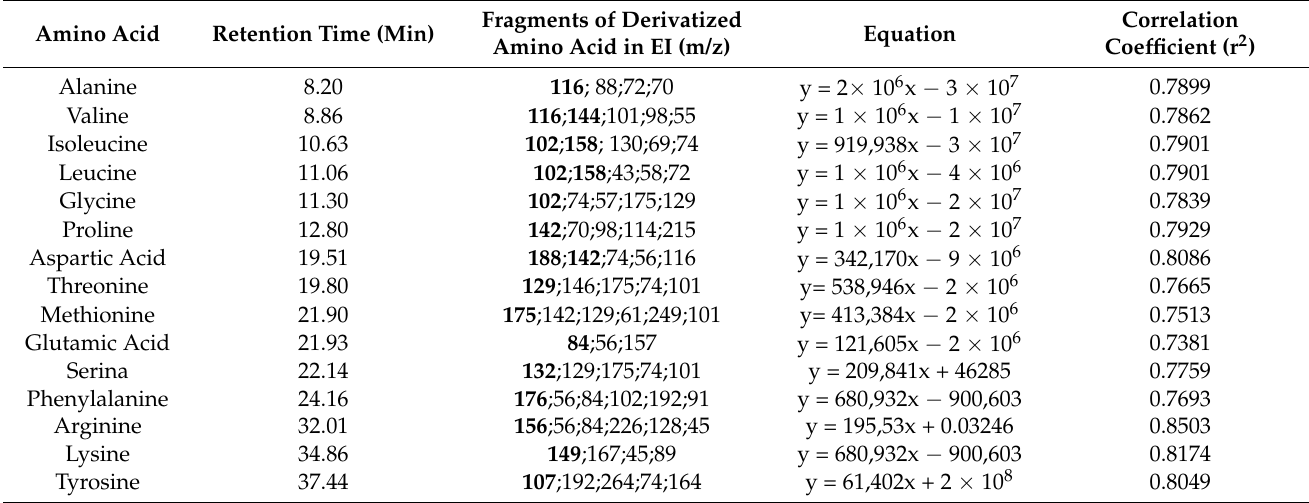
Table 3. Amino acids with respective retention times, characteristic fragments of their derivatives in EI, calibration curve equations, and correlation coefficient (r 2 ). The basic peaks for each individual amino acid are highlighted in